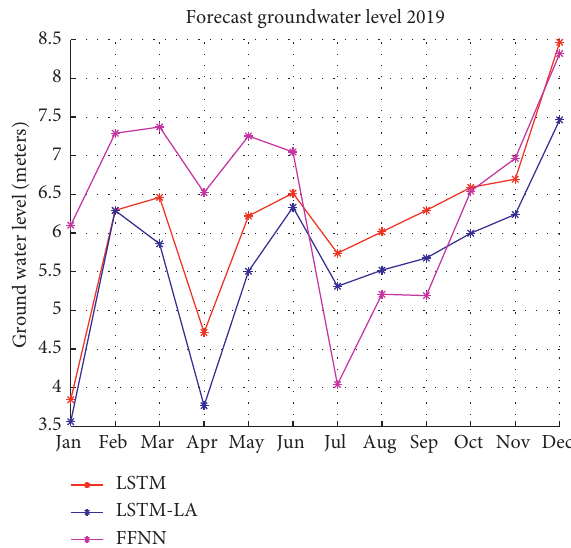
Figure 7: Plot for the forecast groundwater level using LSTM-LA, LSTM, and FFNN